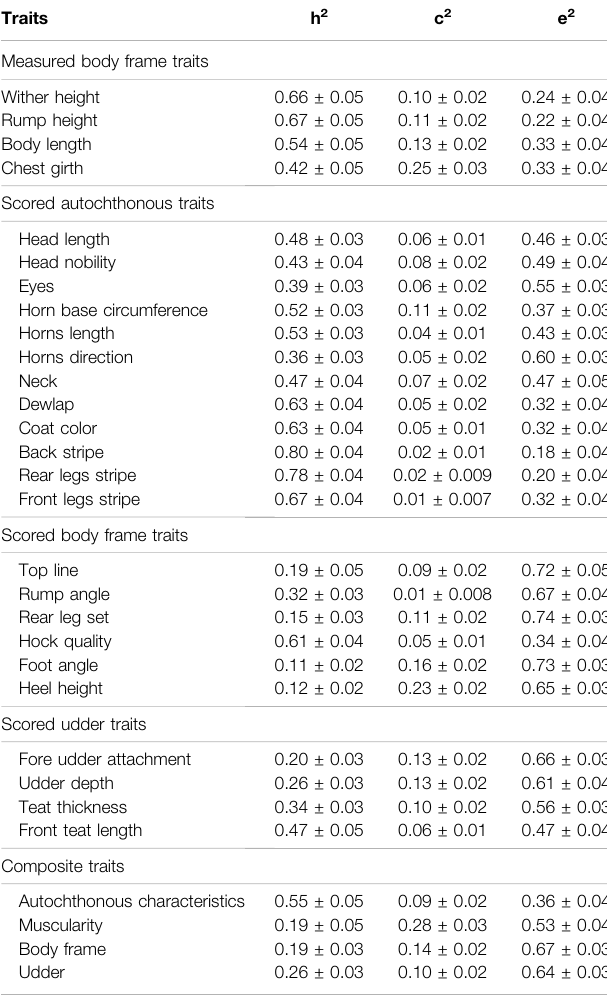
TABLE 3 | Estimated genetic correlations ± standard errors (above diagonal) and phenotypic correlations (below diagonal) for measured body frame traits from Group